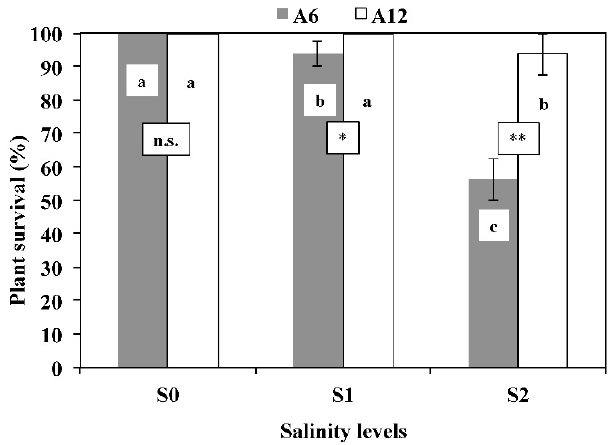
Figure 1. Plant survival (%) in response to different salinity levels (S0, S1, and S2) of two accessions of mastic tree A6 (Manfredonia) and A12 (Specchia). a–c: the letters denote statistically significant differences among salinity levels for each accession ( p = 0.01; Student–Newman–Keuls (SNK) test); the stars denote statistically significant differences between the two accessions for each salinity level (* p = 0.05; ** p = 0.01; n.s. not significant; t ‐ test).